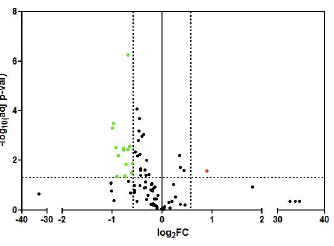
Figure 1. Vulcano plot comparing the 84 gene expression between the Her2 + and TNBC patinets. The genes are represented as log2fold change based on -log10(adjp-value). According to the cut- off of 1.5 fold change (FC) and adjusted p-value of 0.05, the genes in green are underexpressed and the gene in red is overexpressed in TNBC patients compared to Her2 + patients.